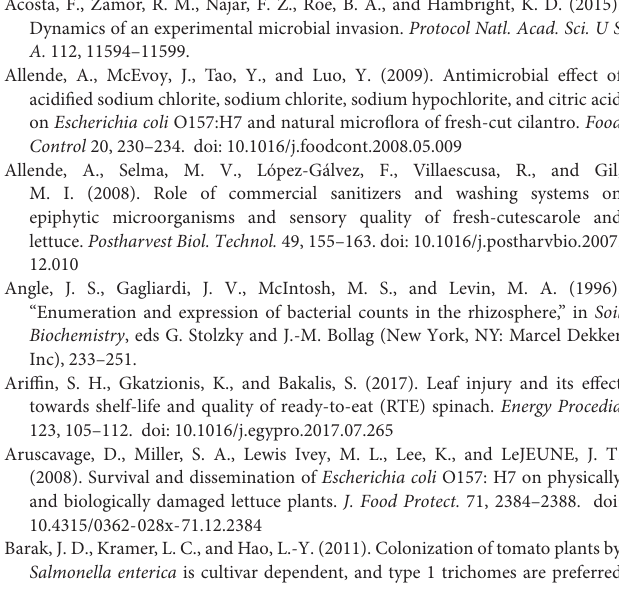
Supplementary Table 1 | E. coli O157:H7 (log CFU × cm − 2 ) re-isolated from wash water of spinach ( Spinacia oleracea L.) leaves from two subsequent washing steps (detachment,